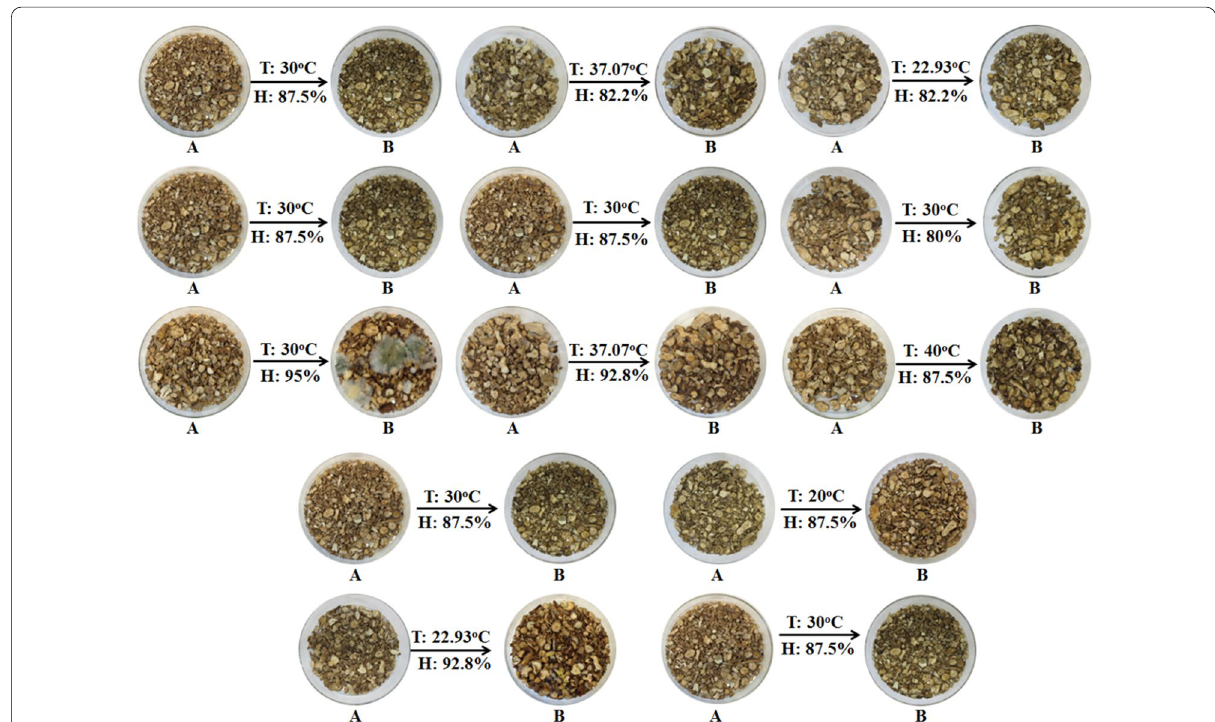
Fig. 2 A. rhizoma samples stored at different temperature and humidity conditions for A 0 and B 10